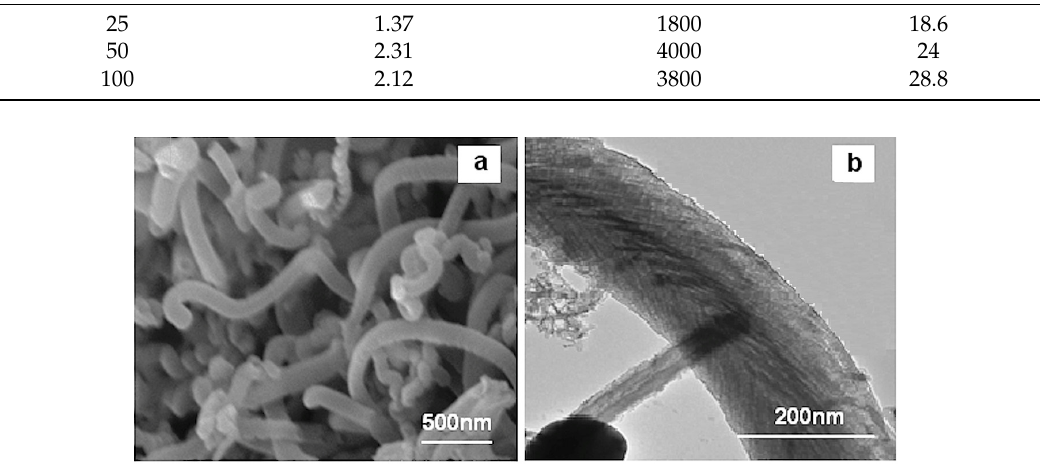
Figure 7. ( a ) SEM and ( b ) transmission electron microscopy (TEM) micrographs of optimum CNF.